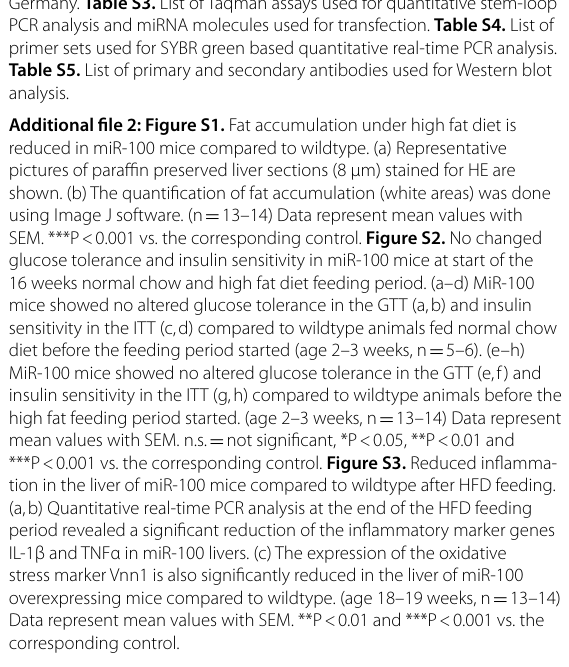
IL-1β and TNFα in miR-100 livers. (c) The expression of the oxidative stress marker Vnn1 is also significantly reduced in the liver of